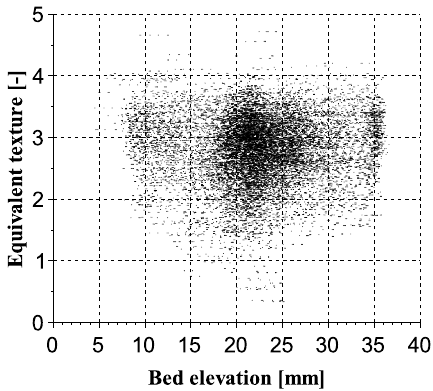
Figure 4. Example of equivalent texture as a function of bed ele- vation for a part of a single DEM: there is no clear trend between the equivalent texture and the local elevation for one set of measure-